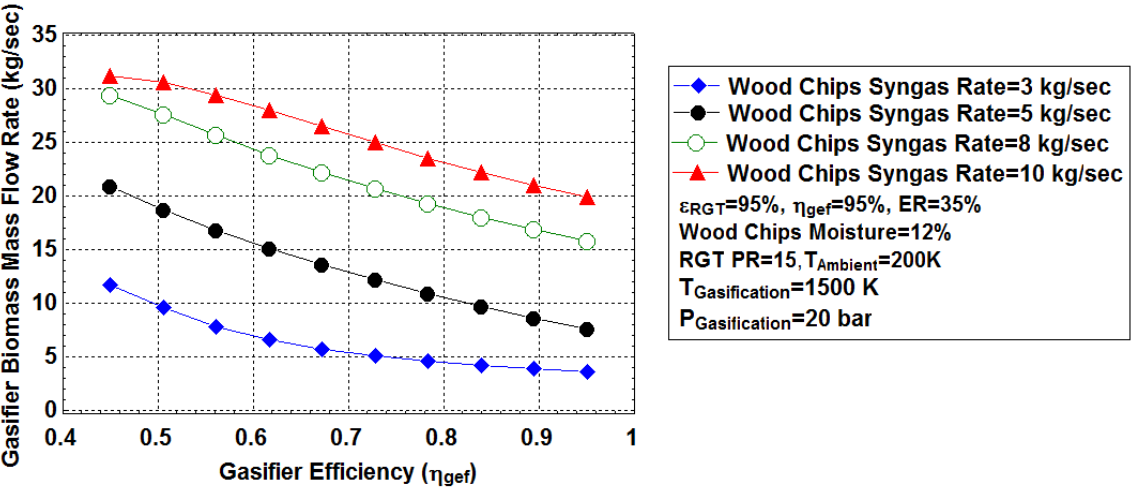
Figure 8. Variation of biomass moisture content with the gasifier’s airflow rate at different gasifica- tion pressures.